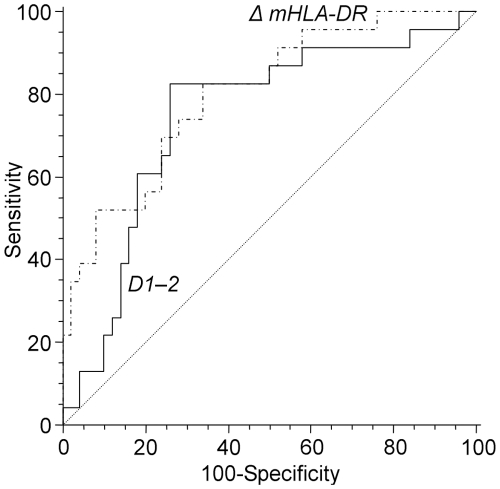
ROC curve of mHLA-DR expression slope (dash line) and IL-6 (full line) for predicting sepsis.Area under curves for mHLA-DR slope (days 3–4 /days 1–2) and IL-6 at days 1–2 were respectively .79 (95%CI .69; .88, p = .0001) and .75 (95%CI .64; .84, p = .0001). The best threshold was 1.1 for mHLA-DR ratio (sensitivity 82.6%, specificity 64.7%) and 67.1 pg/ml for IL-6 concentration (sensitivity 84.6% and specificity 72.5%).